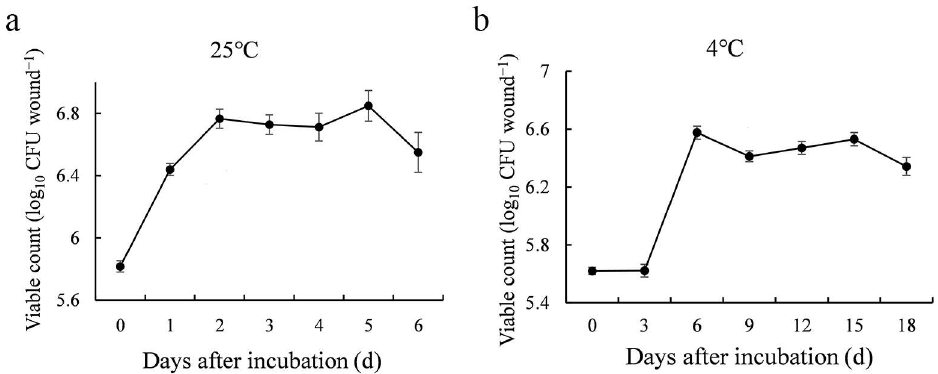
Figure 6. Population dynamics of M. guilliermondii 37 in the wounds of kiwifruit stored at 25 °C ( a ); and 4 °C ( b ). The vertical bars represent the SE of the mean.